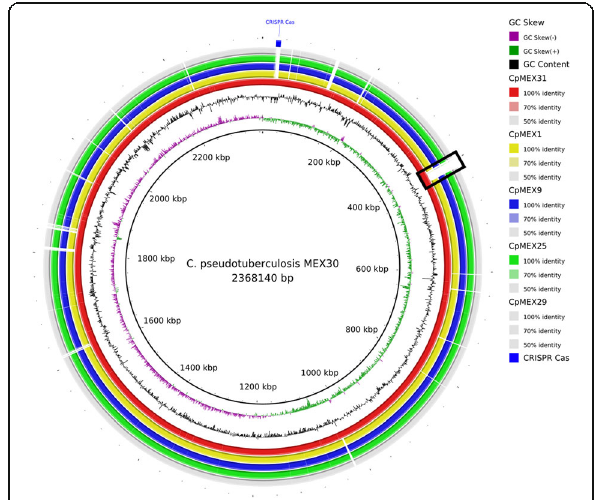
Fig. 3 Circular map of C. pseudotuberculosis strain MEX30 (biovar equi ) in comparison with the other strains of this study. The cluster of CRISPR- Cas, which is only present in biovar equi strains, is highlighted in blue. The nitrate reductase gene cluster is highlighted by a black